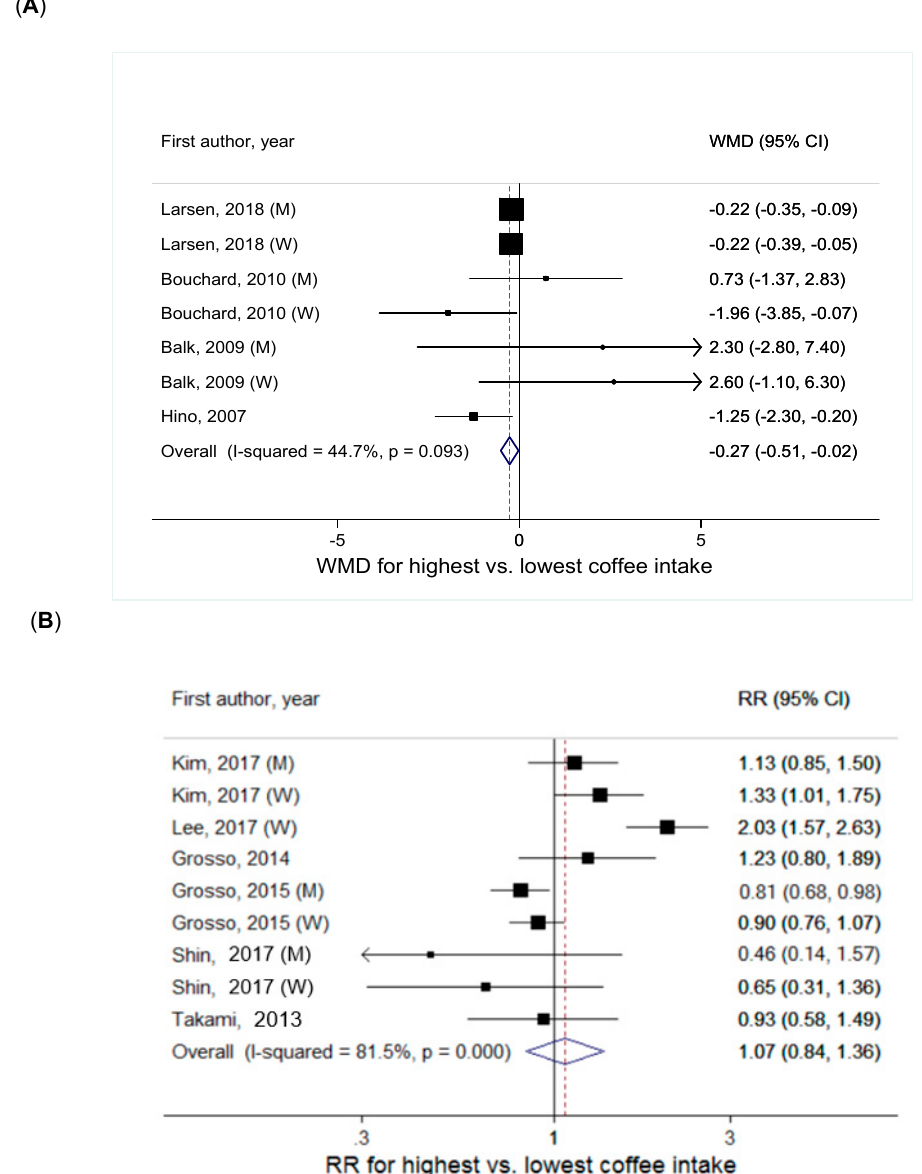
Figure 3. Meta-analysis of coffee intake with ( A ) continuous WC and ( B ) central obesity defined by WC. Abbreviations: CI, confidence interval; M, men; RR, relative risk; W, women; WC, waist circumference; WMD, weighted mean difference.